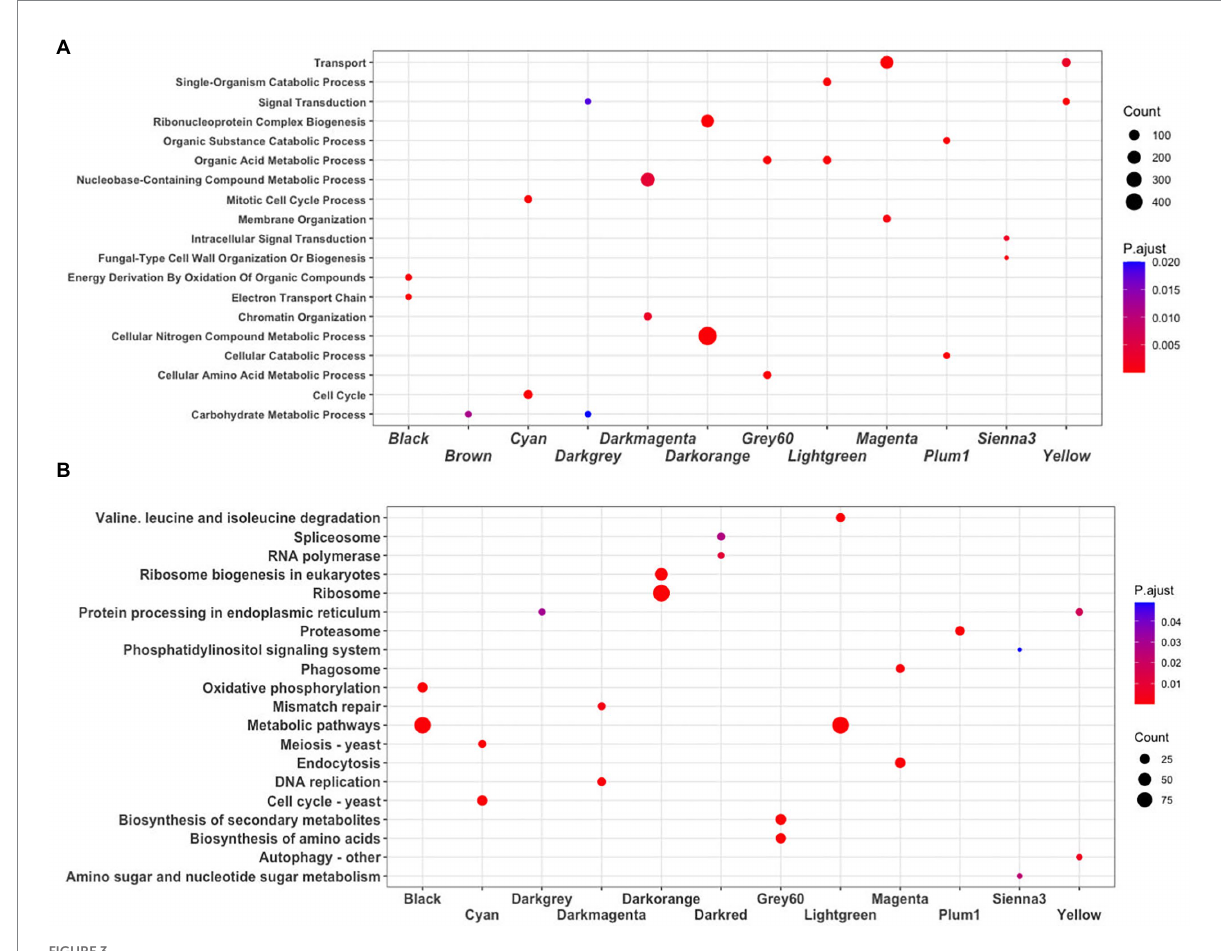
FIGURE 3 Enrichment analysis. (A) Biological process GO terms, and (B) KEGG pathways. The dot plot shows the main terms (FDR < 0.05) identified using DAVID. The size of a dot represents the number of genes associated with each term, and the color of dots represents the p -adjusted values.